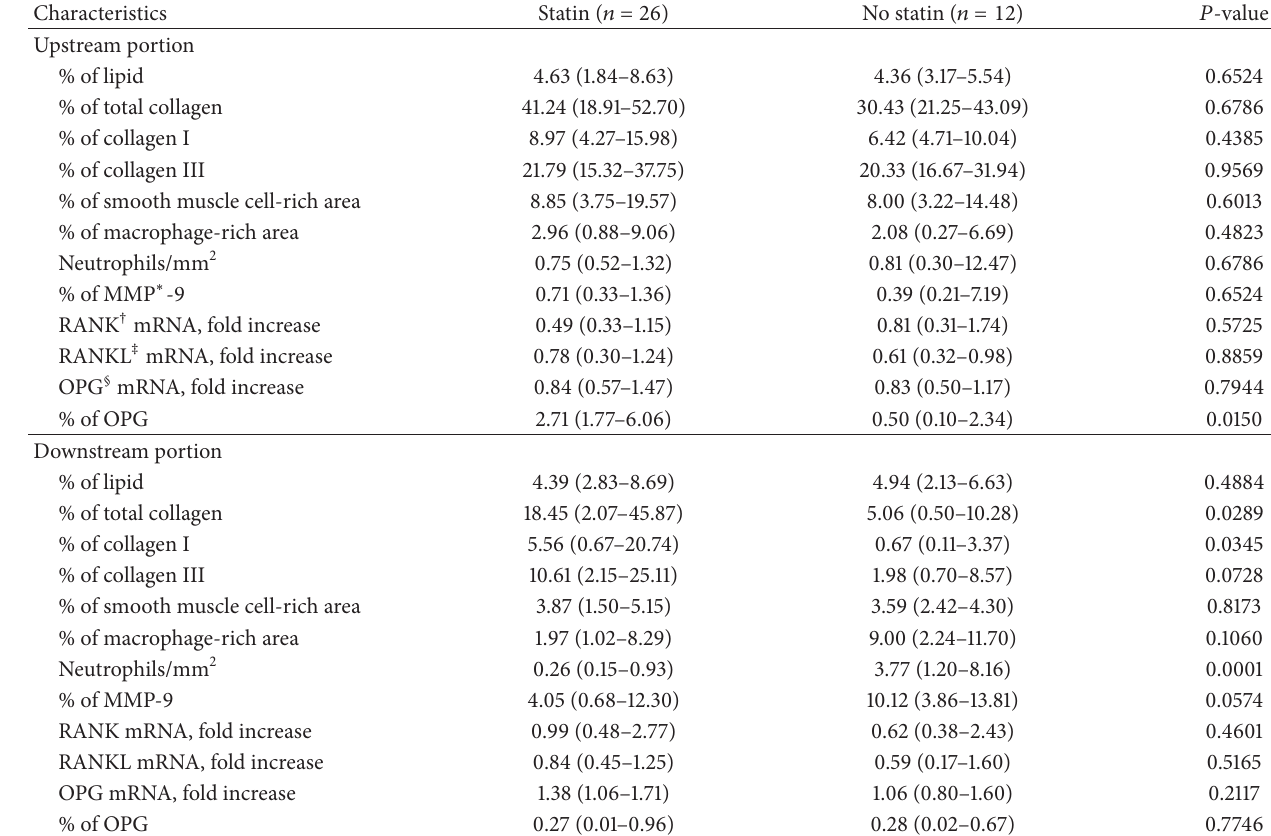
Table 5: Parameters of intraplaque